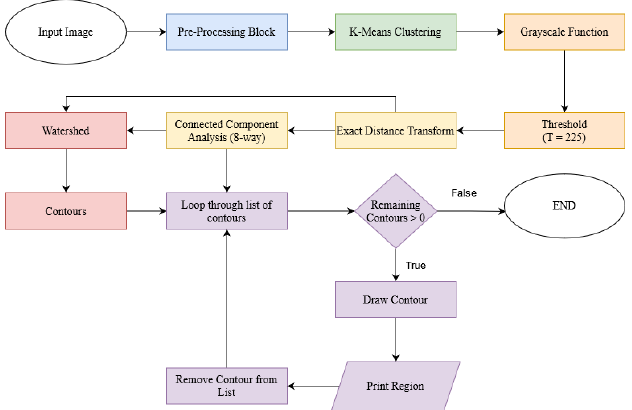
Figure 1. Proposed approach block